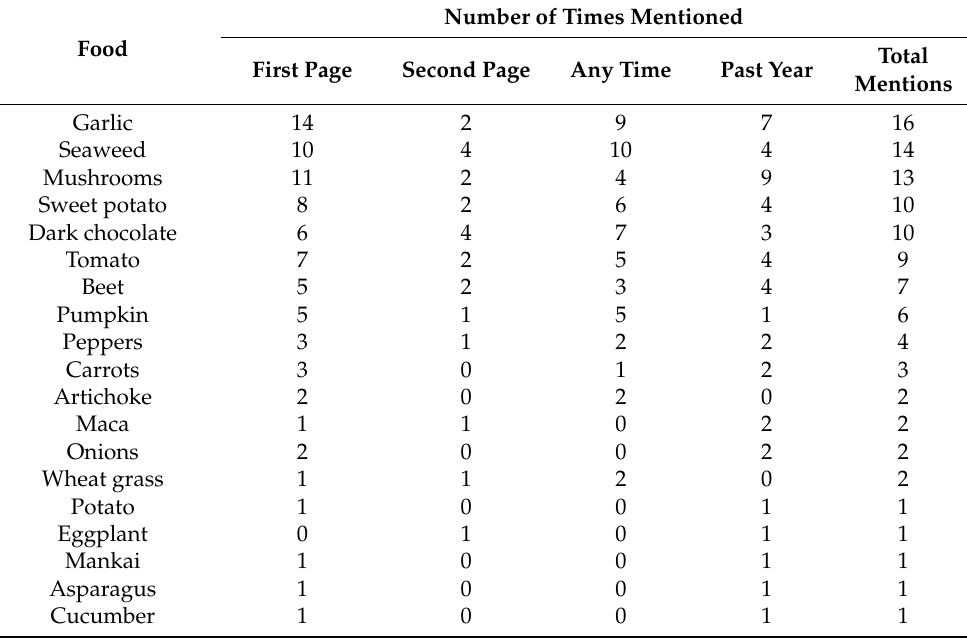
Table 8. Classification of other plant-based foods by the number of times that were mentioned on selected web pages.